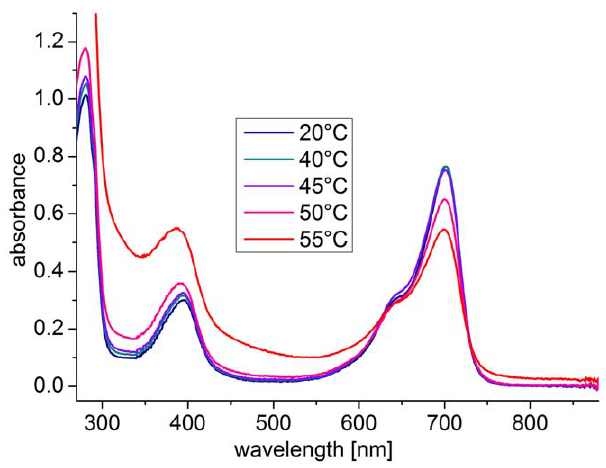
Figure 2. Absorption spectra of the Pr form of Agp1 at various